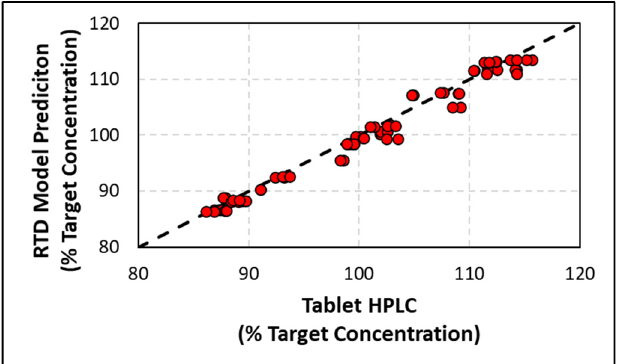
Figure 16. Parity plot for the model validation comparing the measured and predicted tablet con- centration.